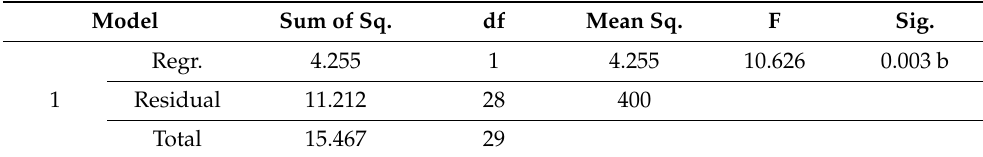
Table 3. E-court system quality and e-court user satisfaction. Model